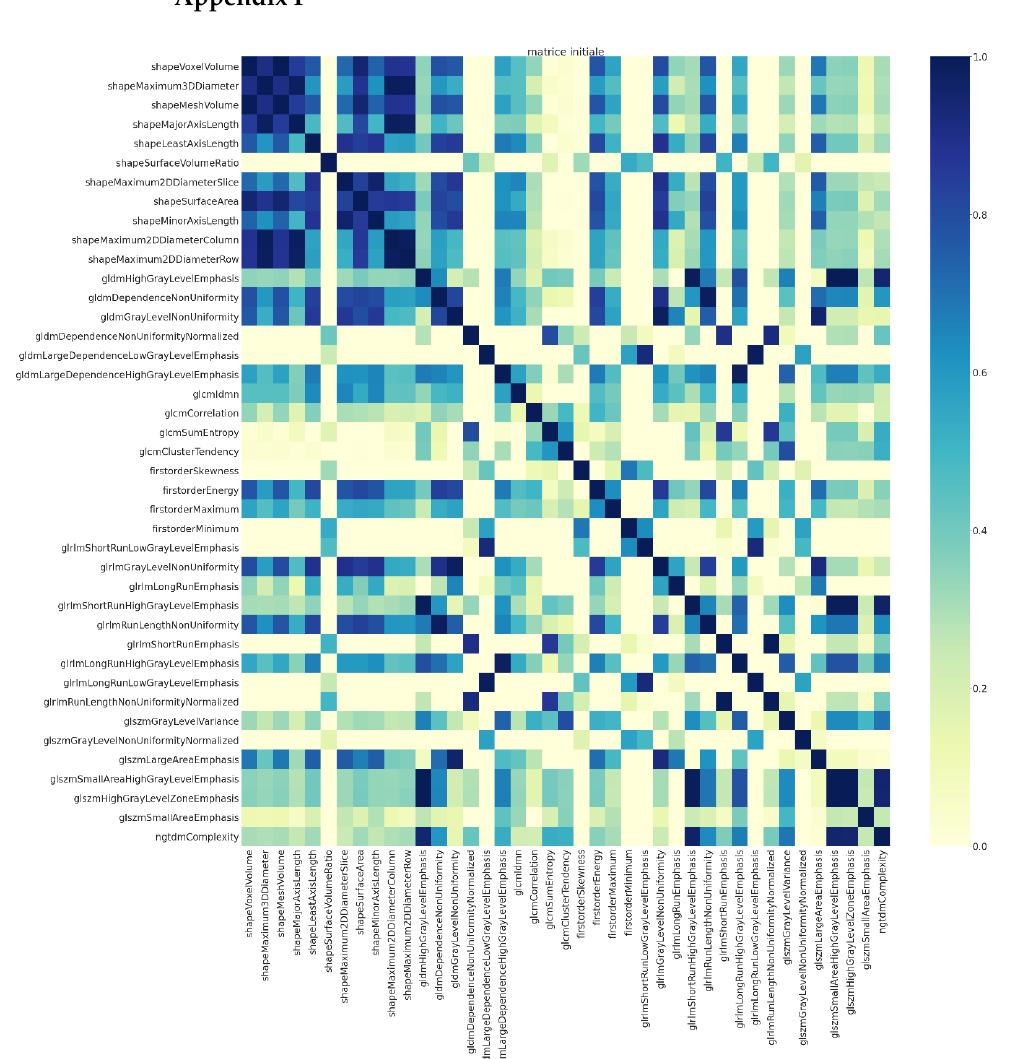
Figure A1. Correlation matrix for redundancy filtering among features.